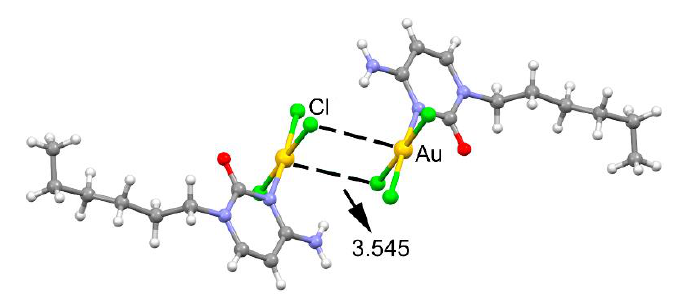
Figure 5. Self-assembled dimer of trichlorido-(1-hexylcytosine)gold(III) complex. Distance in Å.